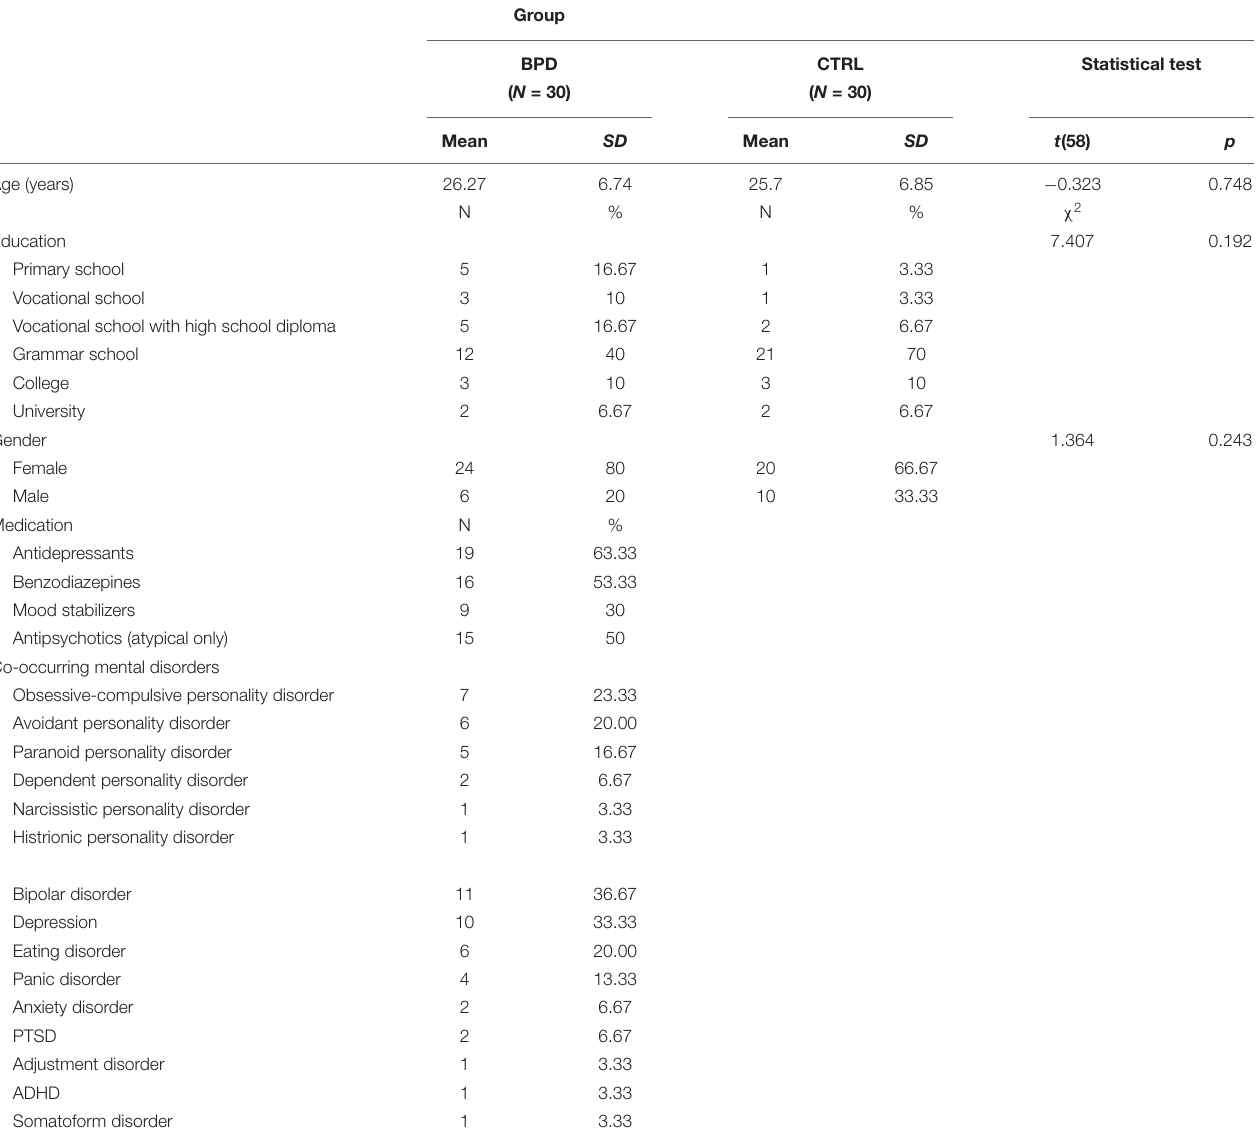
TABLE 1 | Demographics and clinical description of the BPD